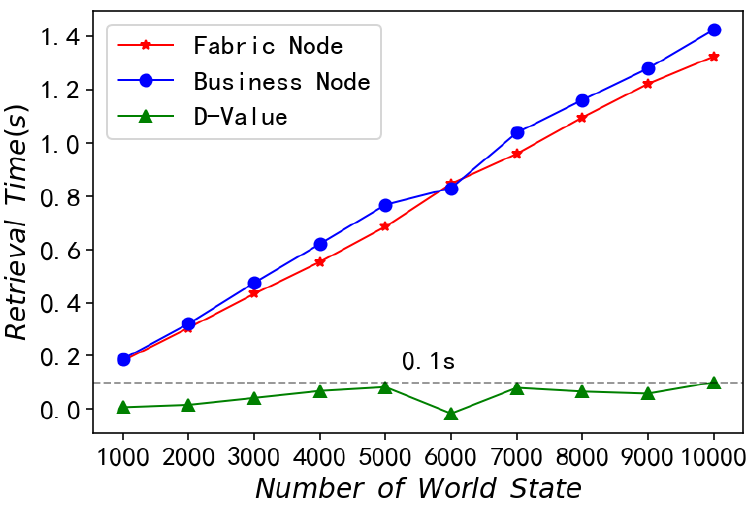
Figure 15. Retrieve state data